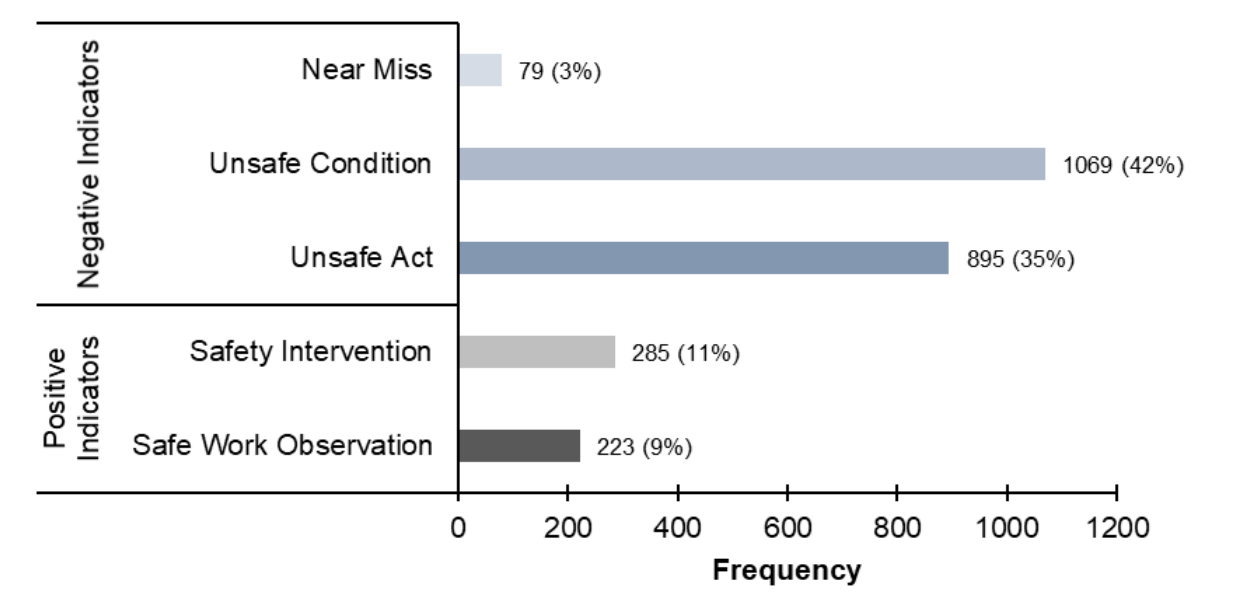
Figure 3. Statistics of safety leading indicators.